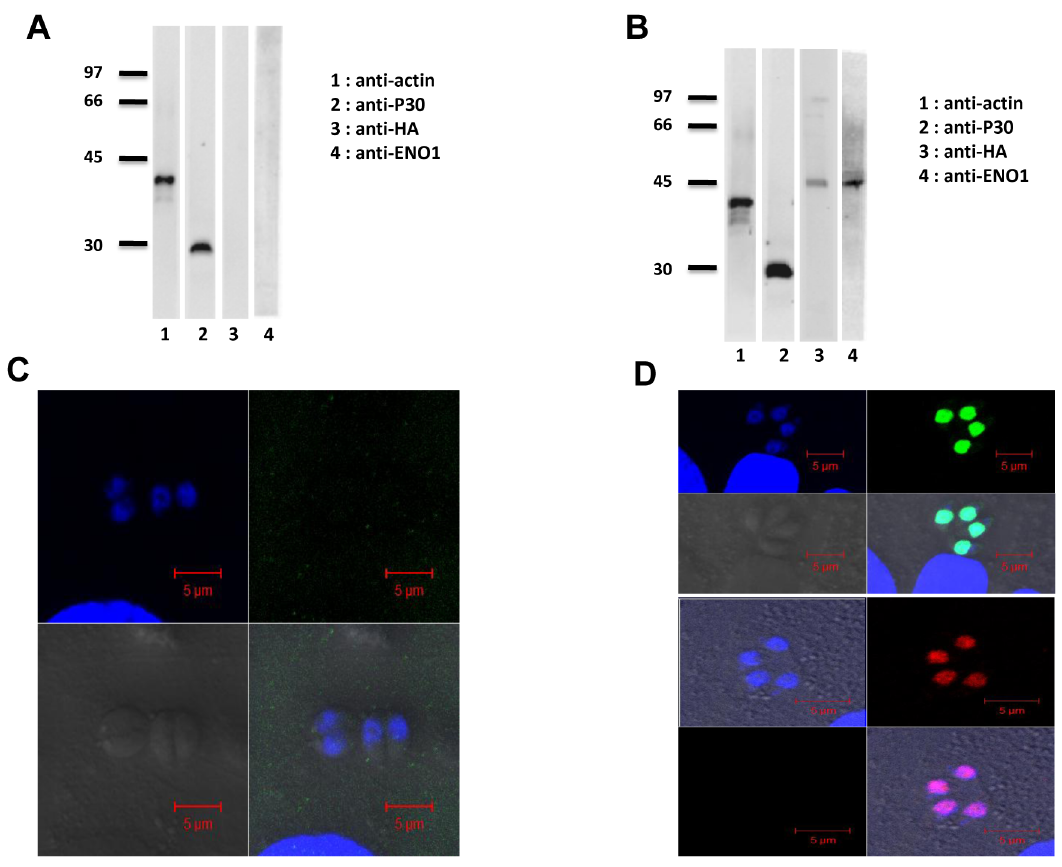
Figure 7. Complementation of Pru D ku80 D Tgeno1 knockout mutant by ectopic expression of TgENO1-HA under tachyzoite culture conditions. A) Western blot analysis of Pru D ku80 D Tgeno1 mutants using total SDS-extracted antigens from approximately 2 6 10 6 tachyzoites and probed with monoclonal antibodies specific to T. gondii actin (a housekeeping protein, lane 1), tachyzoite-specific major surface protein 1 or SAG1 (anti-P30, lane 2), the influenza hemagglutinin (HA)-tag (anti-HA, lane 3) and TgENO1 (lane 4). B) Western blot analysis of total SDS-extracted antigens from approximately 2 6 10 6 intracellular tachyzoites from complemented Pru D ku80 D Tgeno1 mutants and probed with antibodies specific to T. gondii actin (lane 1), tachyzoite-specific major surface protein 1 or SAG1 (anti-P30, lane 2), the influenza hemagglutinin (HA)-tag (anti-HA, lane 3) and TgENO1 (lane 4). C) Confocal microscopy of intracellular tachyzoites of Pru D ku80 D Tgeno1 mutants that were grown in confluent HFF cells and stained with polyclonal anti-HA antibodies. The panels show nuclei stained by DAPI (upper left panel), IFA (upper right panel), phase contrast (lower left panel), and merged image (lower right panel). Scale bars are 5 m m. D) Confocal microscopy of intracellular tachyzoites from Pru D ku80 D Tgeno1 mutants that were complemented with TgENO1-HA plasmid and grown in confluent HFF cells. The first four upper panels show staining with polyclonal anti-HA antibodies (green). The second four lower panels show double staining with FITC-labeled dolichol biflorus lectin (cyst wall marker, green) and polyclonal anti-HA antibodies (red). The panels show nuclei stained with DAPI (upper left panel, blue), IFA (upper right panel, green or red), phase contrast (lower left panel), and merged image (lower right panel). Scale bars are 5 m m.